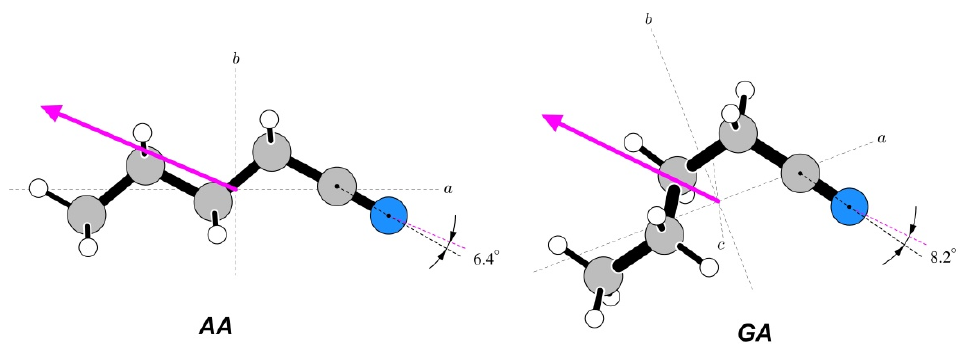
Figure 10. Orientations of the measured dipole moments in the two studied conformers of n -butyl cyanide. Both molecules are rotated, such that the CCN atom segment is in the plane of the diagram and at a comparable orientation. The marked angles are between the CN axis and the dipole moment direction.